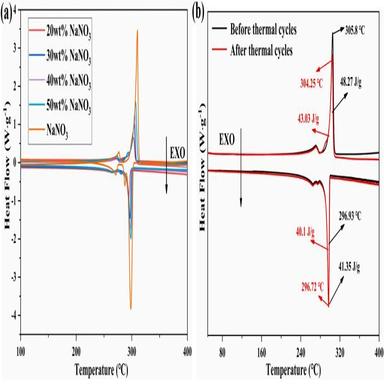
DSC curves of the (a) ss-CPCM samples with various NaNO3 contents and (b) ss-CPCM with 50 wt% NaNO3 before and after 100 heat thermal cycles. EXO refers to the exothermic direction.